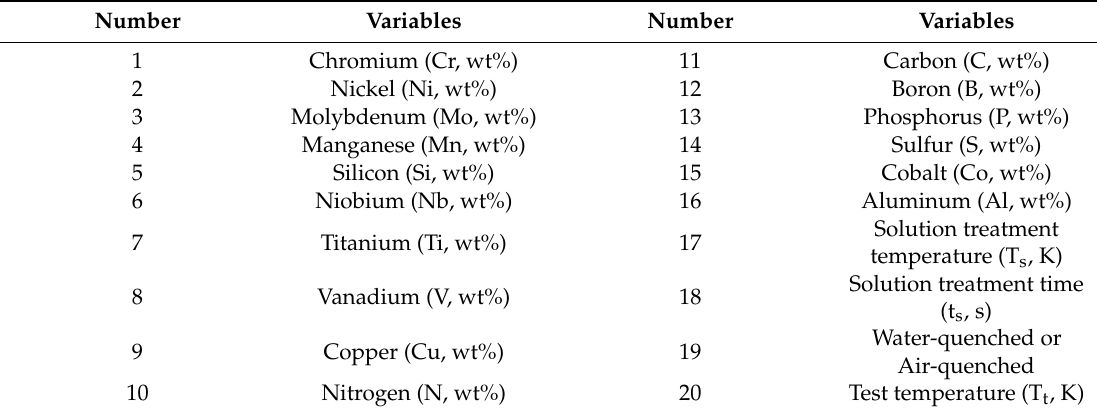
Table 1. The input variables of austenitic stainless steel in this